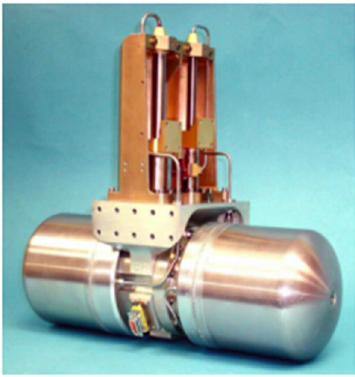
Figure 16. NGAS two-stage high capacity cryocooler 42